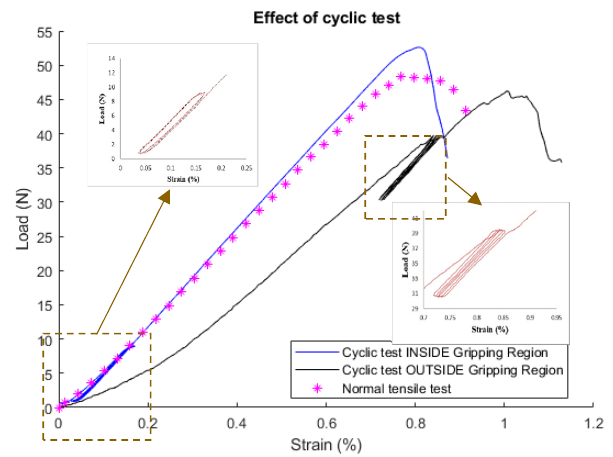
Figure 13. Cyclic test outside the gripping region with hysteresis behavior.